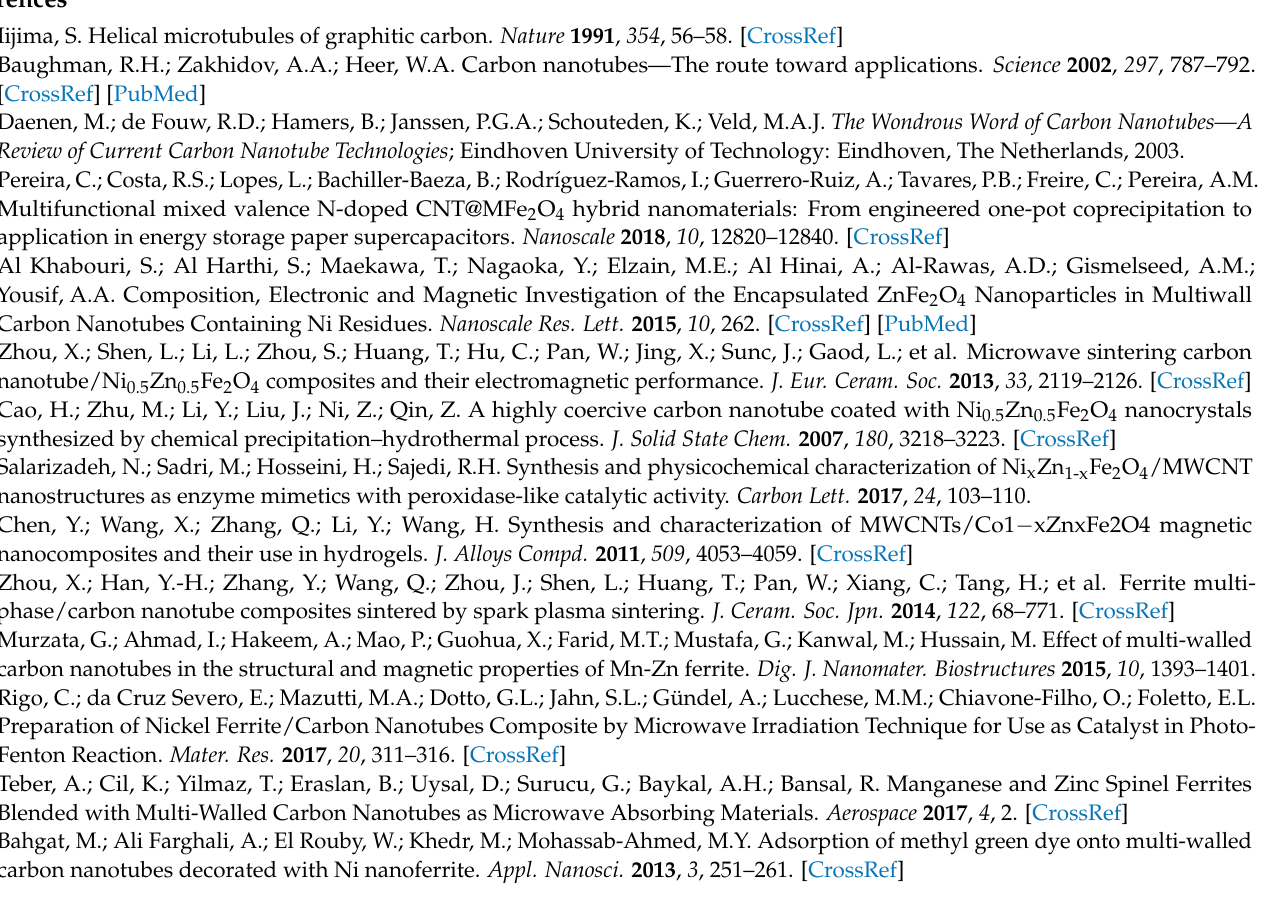
Table S4. The results of S2p core level lines fit pristine and calcined f-MWCNTs nanotubes; Table